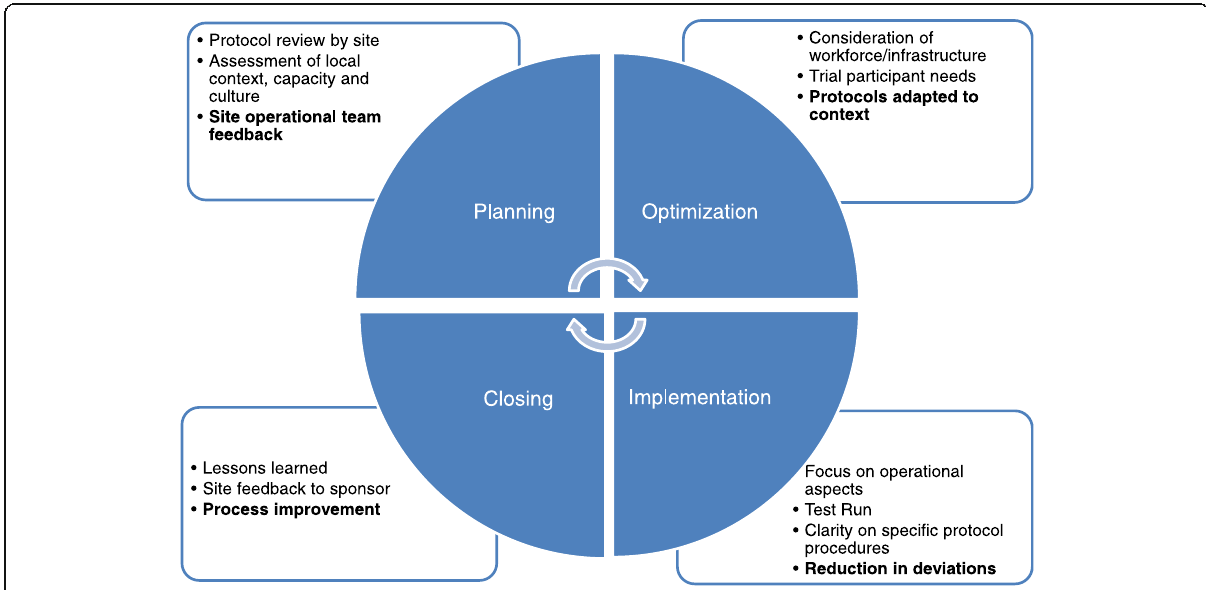
Fig. 4 Implementation of measures to increase protocol